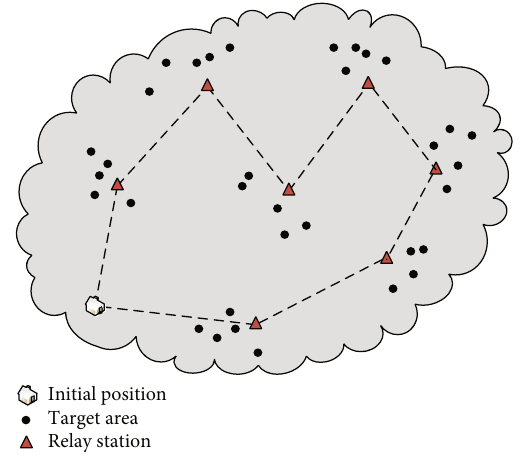
Figure 1: An example of the cooperative problem for the multitasks by a hybrid UAV/UGV system.